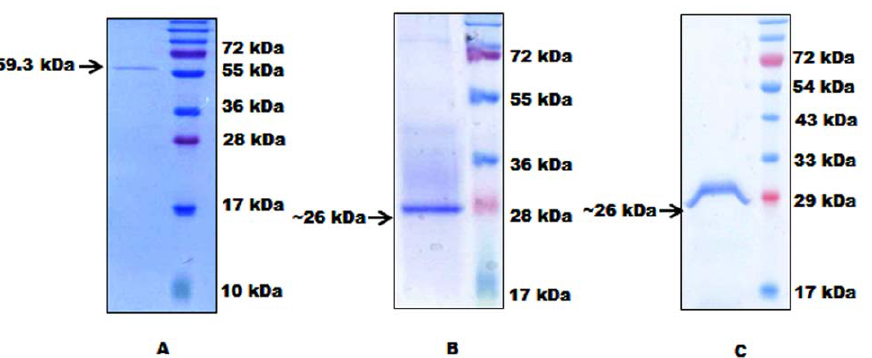
Figure 2. Affinity chromatographic purification of Rv1430 full-length protein, PE-PPE and Ser199Ala PE-PPE domains. Eluted fractions of the proteins recovered during the various purification steps were separated by SDS–12% polyacrylamide gel electrophoresis and stained with Coomassie brilliant blue R250. (A) Purified protein full-length Rv1430 (59.3 kDa); (B) Purified PE-PPE domain of Rv1430 (25.8 kDa); (C) Purified mutated PE-PPE domain of Rv1430 (25.8 kDa).